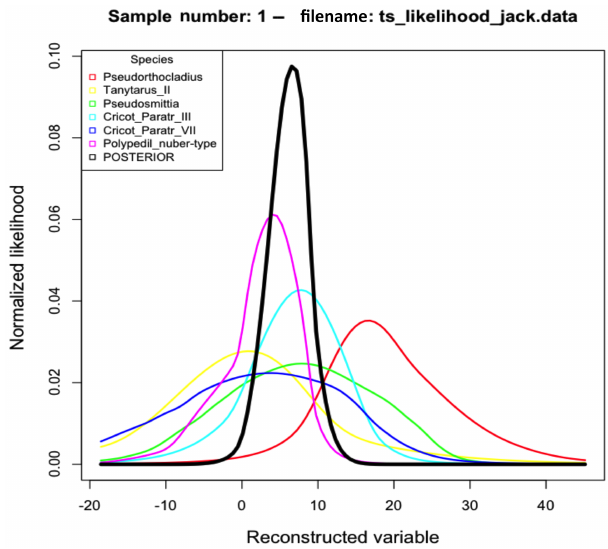
Figure B1. Illustrative output of BUMPERpp.R reconstruction vi- sualization